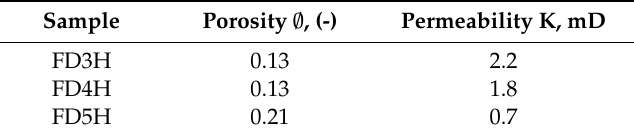
Figure 1. Schematic of M9300 core flow loop. Table 1. Showing properties of core samples.